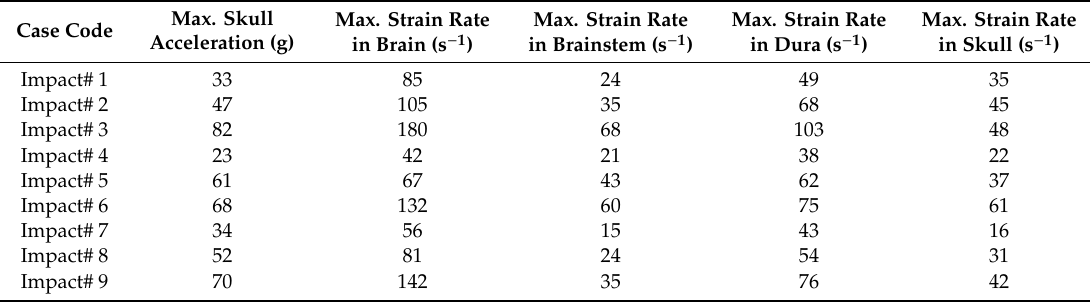
Table 6. The estimated maximum linear acceleration of skull, and strain rate of the brain, brainstem, skull, and dura at di ff erent impact